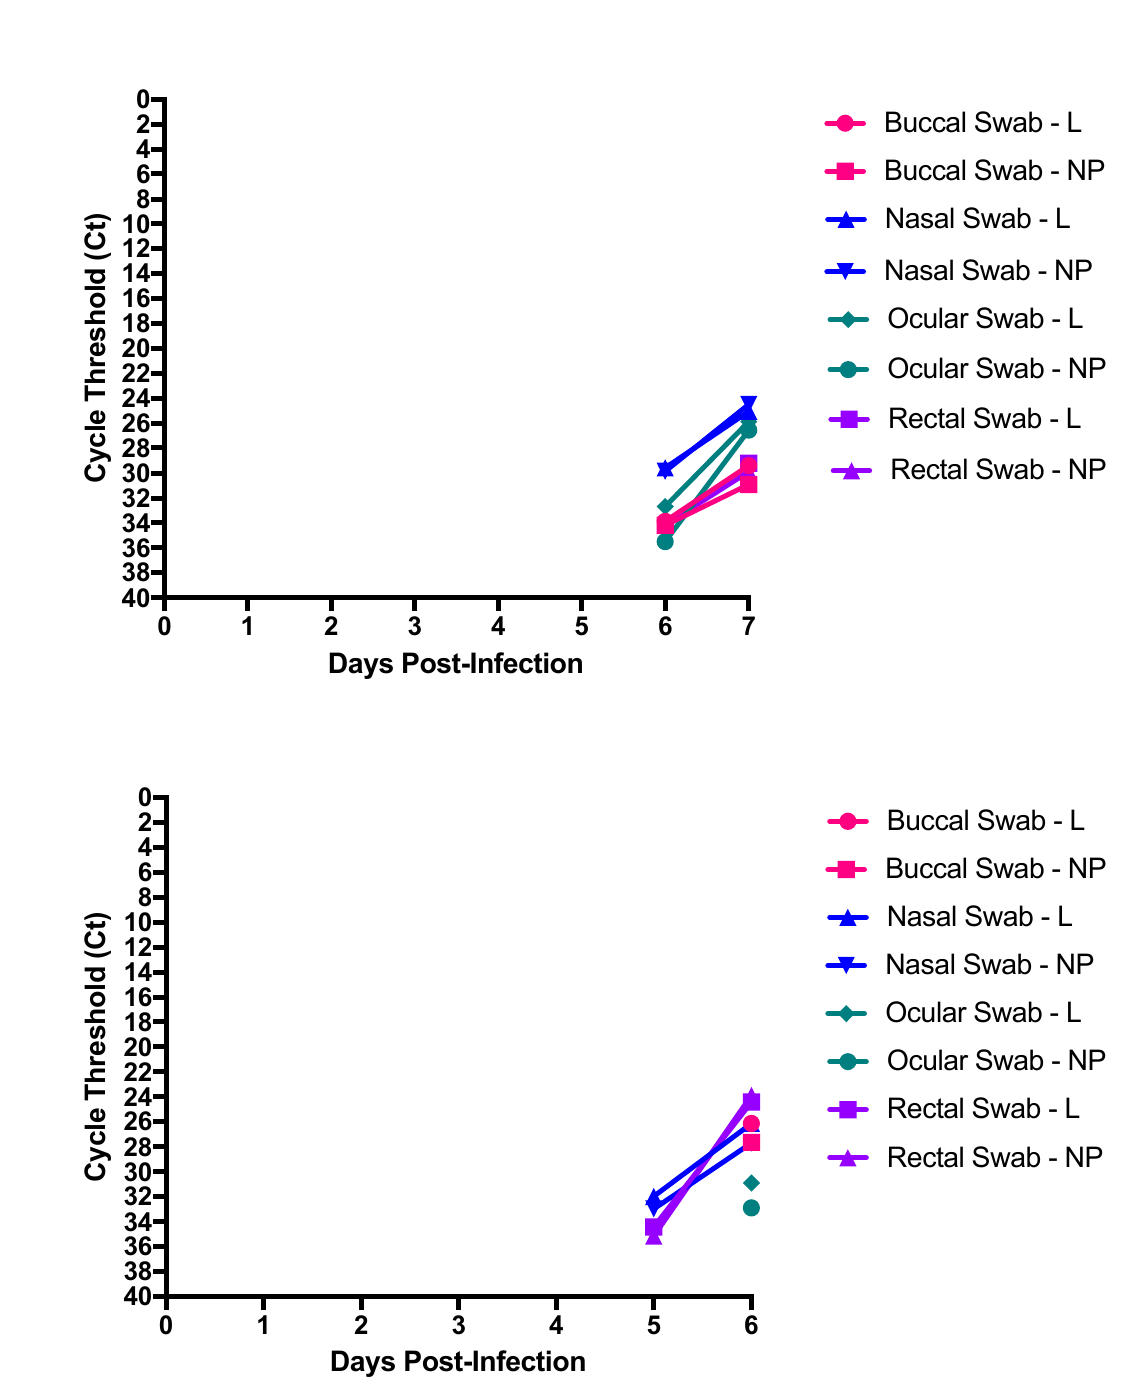
Figure 3. Detection of viral RNA in clinical swabs throughout disease course. Buccal, nasal, ocular, rectal, and skin swabs were collected 1–2 weeks before study initiation, and daily throughout the course of clinical disease. All samples were extracted, reverse transcribed, and then quantified using two targets for EBOV RNA, buccal L-gene ( • ) and NP- targets ( (cid:4) ), nasal L-gene ( (cid:78) ) and NP- targets ( (cid:72) ), ocular L-gene ( (cid:7) ) and NP-targets ( • ), rectal L-gene ( (cid:4) ) and NP-targets ( (cid:78) ), skin L-gene ( (cid:72) ), and NP-targets ( (cid:7) ) for ( A ) NHP 1 and ( B ) NHP 2.